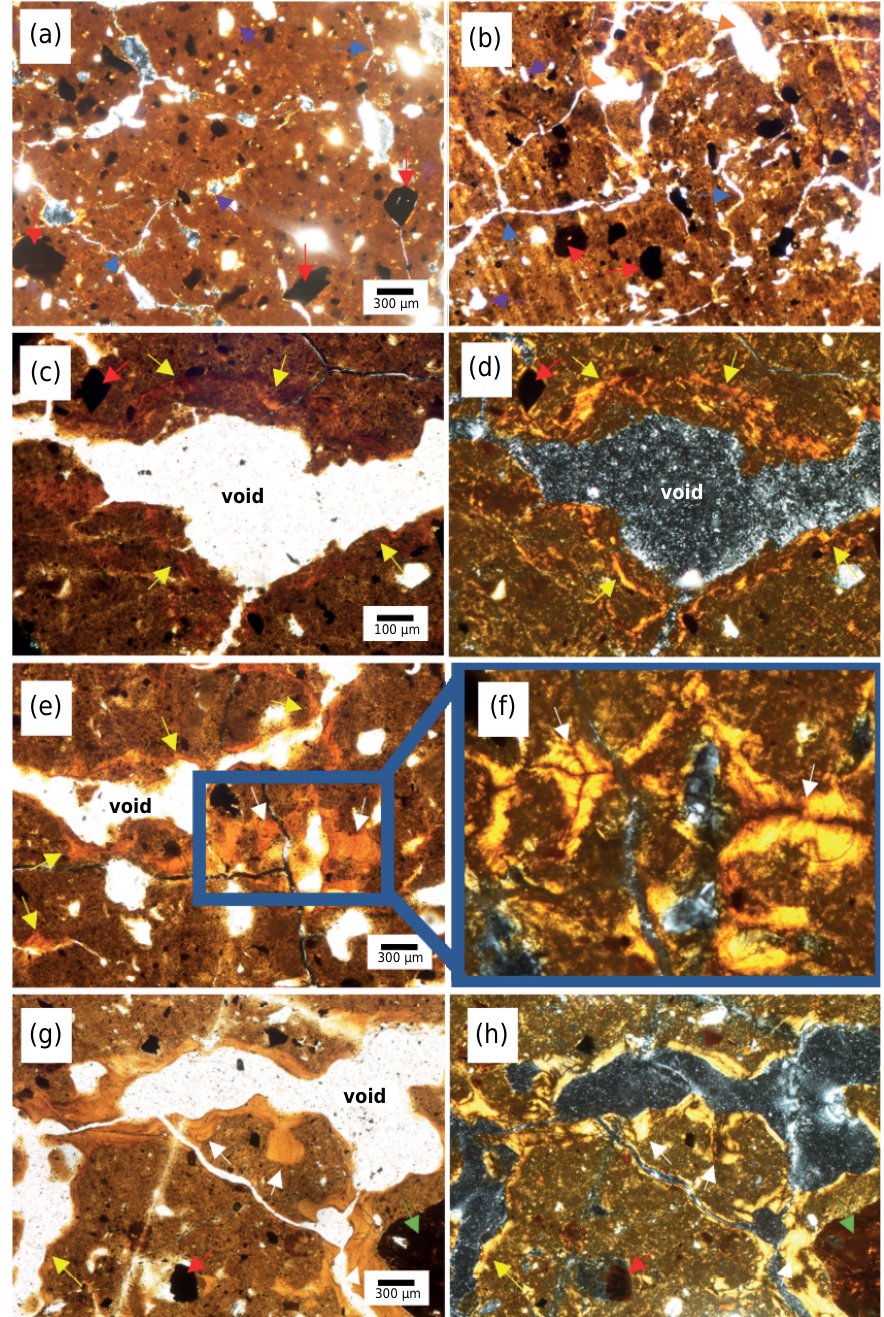
Figure 5. Representative photomicrographs of Bt horizons, highlighting: a and b – block microstructure with planar voids; c and d – monostriated b-fabric associated with clay orientation due to the mechanical expansion and contraction of soil mass; e and f – textural pedofeatures, such as clay coatings and infillings formed by local clay illuviation and deposition; g and h – textural pedofeatures, similar to the previous figures, with striaded b-fabric. Photomicrographs in parallel polarized light: a, b, c, e, and g. Photomicrographs in crossed polarized light: d, f, and h. Symbology: blue arrows – planar voids; orange arrows – compound packing voids; purple arrows – vughs; red arrows - ilmenite with alteration (leucoxene) or magnetite with alteration (hematite); yellow arrows – clay orientation with monostriated b-fabric interpreted with a product of mechanical stress by physico-hydrical constraints; white arrows – clay coatings or infillings; and green arrows – Fe-Mn-typical